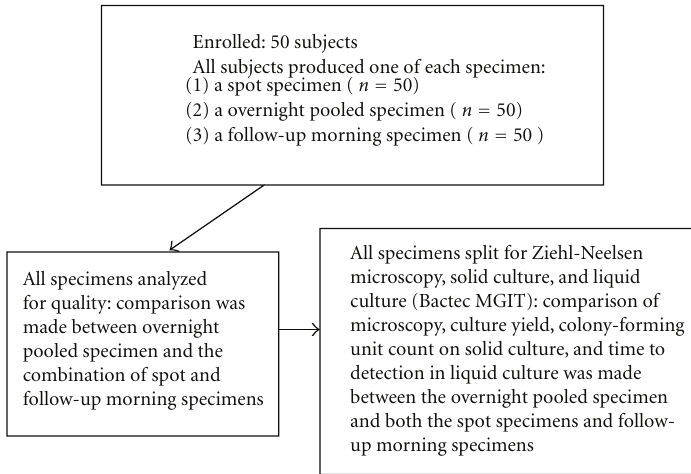
Figure 1: Study diagram of enrollment and specimen analysis.